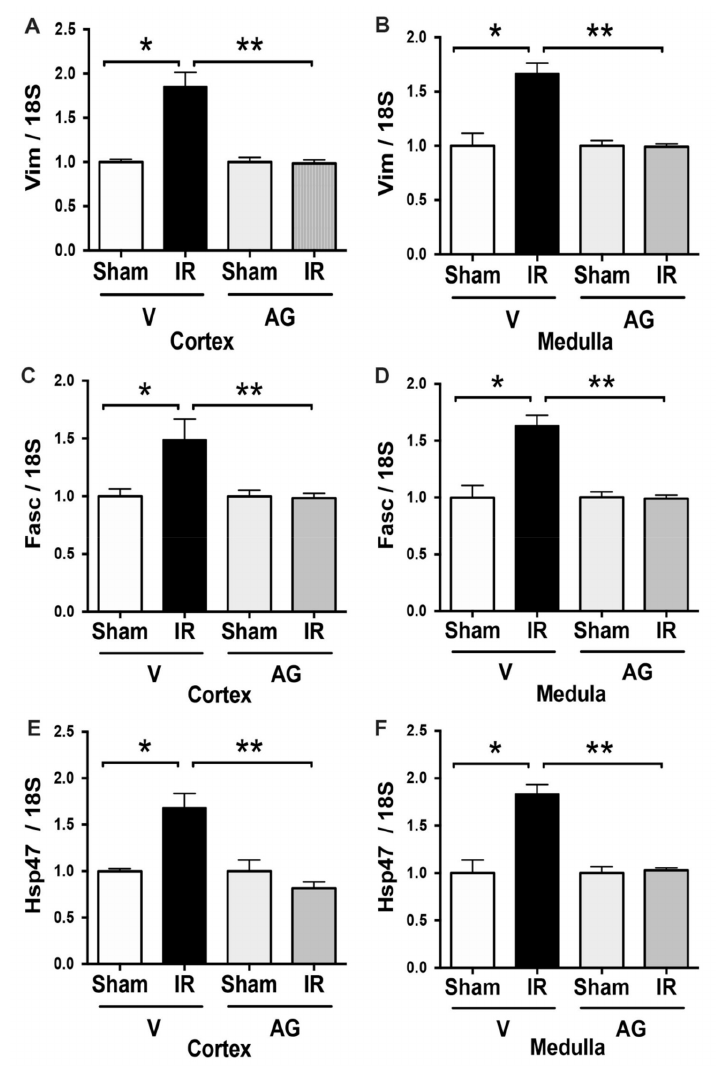
Figure 8. AG inhibited vimentin, fascin, and Hsp47 mRNA upregulation during IR. BALB/c mice were treated with either vehicle or AG (50 mg/kg i.p) before sham or subjected to 30 min of ischemia and 48 h of reperfusion (IR). Vimentin, fascin, and Hsp47 mRNA expression were determined by qPCR in sham (n = 5), IR (n = 5), AG-sham (n = 6), and AG-IR (n = 6). ( A ) Vimentin mRNA in the cortex. ( B ) Vimentin mRNA in the medulla ( C ) Fascin mRNA in the cortex. ( D ) Fascin mRNA in the medulla. ( E ) Hsp47 mRNA in the cortex. ( F ) Hsp47 mRNA in the medulla. The bar graph represents mean ± SEM, and the data were analyzed using ANOVA non-parametric Kruskal–Wallis test. * p < 0.05, ** p <